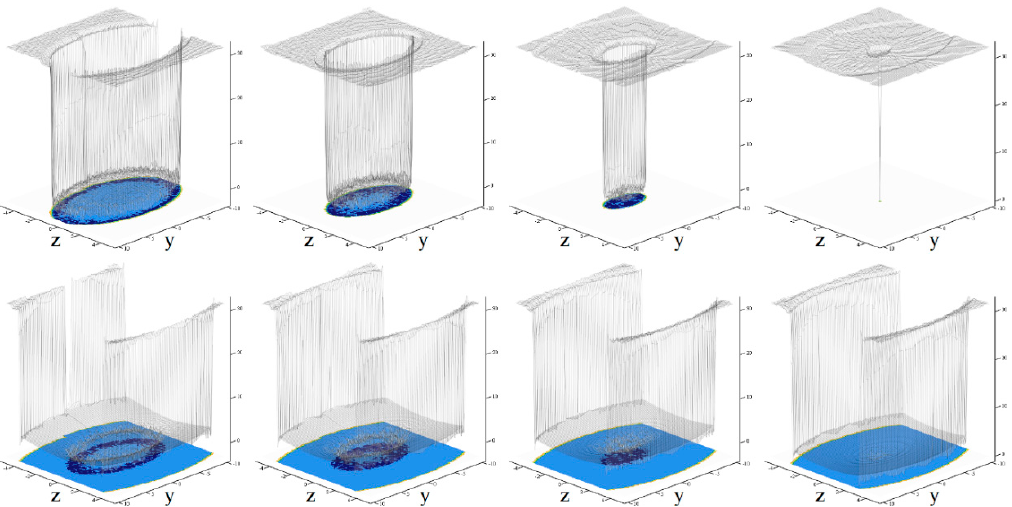
Figure 5. Basin of attraction: topographically colored surface contour plot of the log-scaled final system energy, original dynamical system with hyperbolic equilibria (upper set of pictures) and system with parallel lines as equilibria (lower set of pictures).